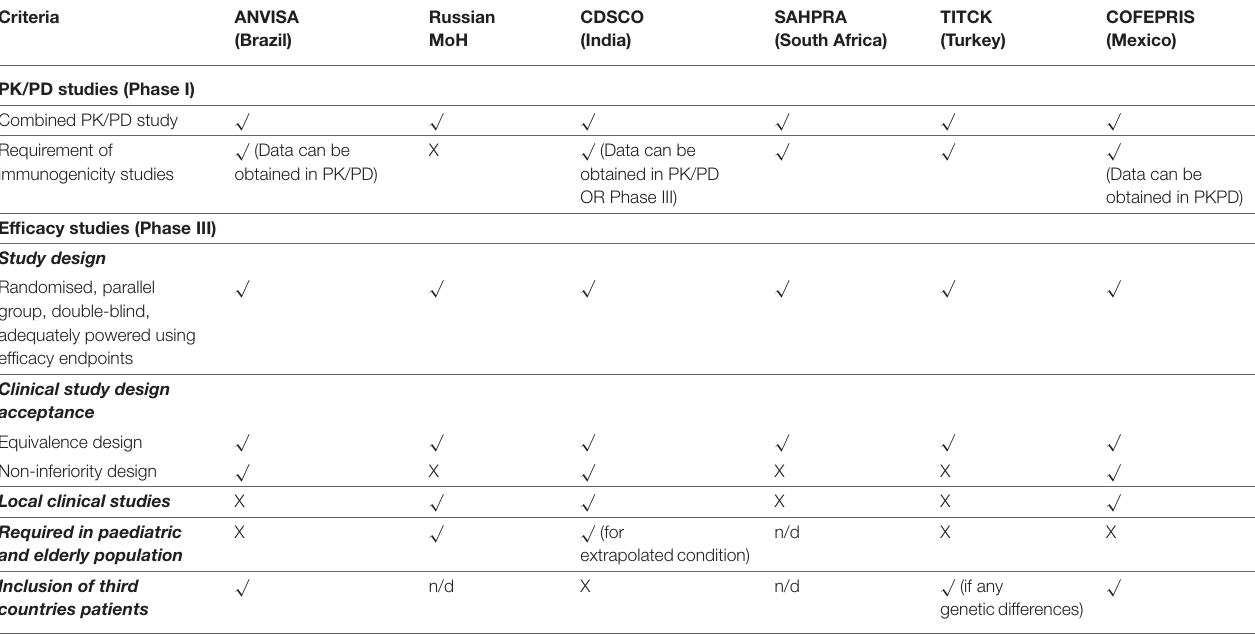
TABLE 4 | Clinical trial requirements for biosimilar development in emerging